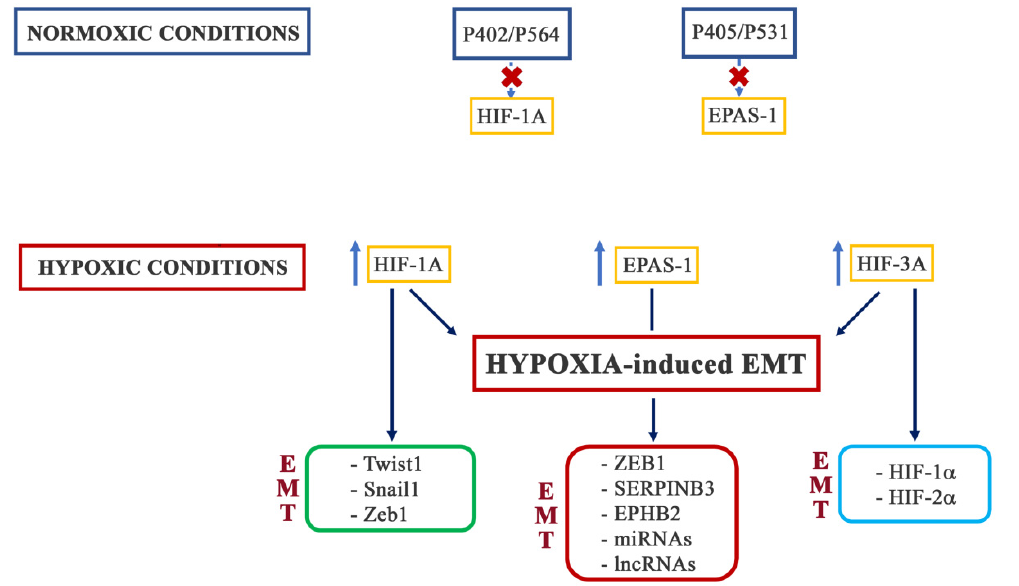
Figure 4. Regulation of EMT by hypoxia through the induction of HIF-1, EPAS-1 (HIF-2), and HIF- 3 transcription factors (HIF-dependent EMT induction). HIF-1 and HIF-2 directly regulate transcrip- tion factors directly or indirectly involved in EMT. On the other hand, the little that is known about HIF-3 suggests control over HIF-1 α and HIF-2 α more than a direct effect on EMT-transcription fac-